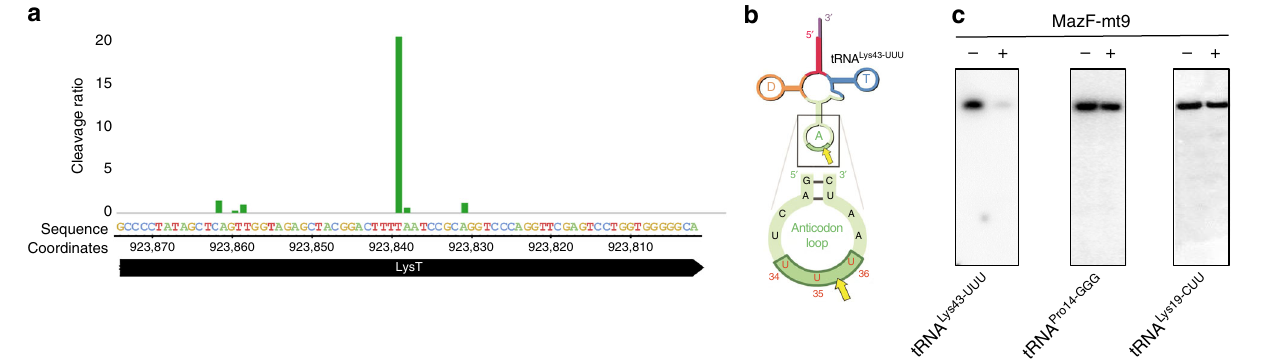
Fig. 1 MazF-mt9 targets only tRNA Lys43-UUU in vivo. a Histogram representing the ratio of cleavage by MazF-mt9 identi fi ed using 5 ′ RNA-seq at each nucleotide within the lysT gene (tRNA Lys43-UUU ) in M. tuberculosis H37Rv after 7 days of toxin induction. Genomic positions and the negative strand sequence are shown. b Representation of the only MazF-mt9 target, tRNA Lys43-UUU (adapted from Schifano et al. 15 ). Anticodon (UUU), in red; cleavage site, yellow arrow. c Northern analysis of RNA from ±MazF-mt9 M. tuberculosis cells using the tRNA isoacceptor-speci fi c oligonucleotides indicated. Uncropped Northern blot images are provided as a tab within the Source Data fi